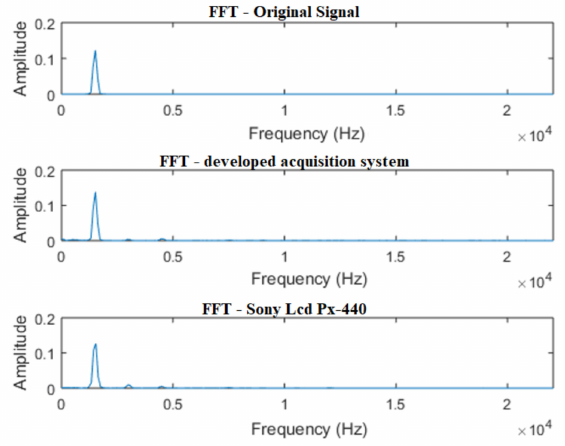
Figure 15. FFT of a single tone signal—1500 Hz sine